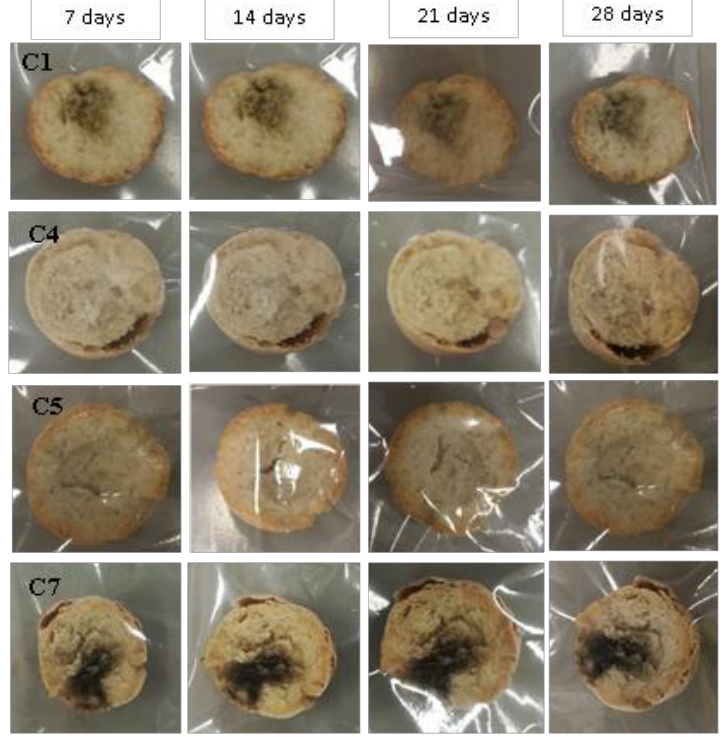
Figure 9. Examples of bread made from sourdoughs inoculated with the combination of isolates C1, C4, C5, and C7, and then artificially contaminated with Aspergillus niger and incubated at room temperature for 7, 14, 21, and 28 days.